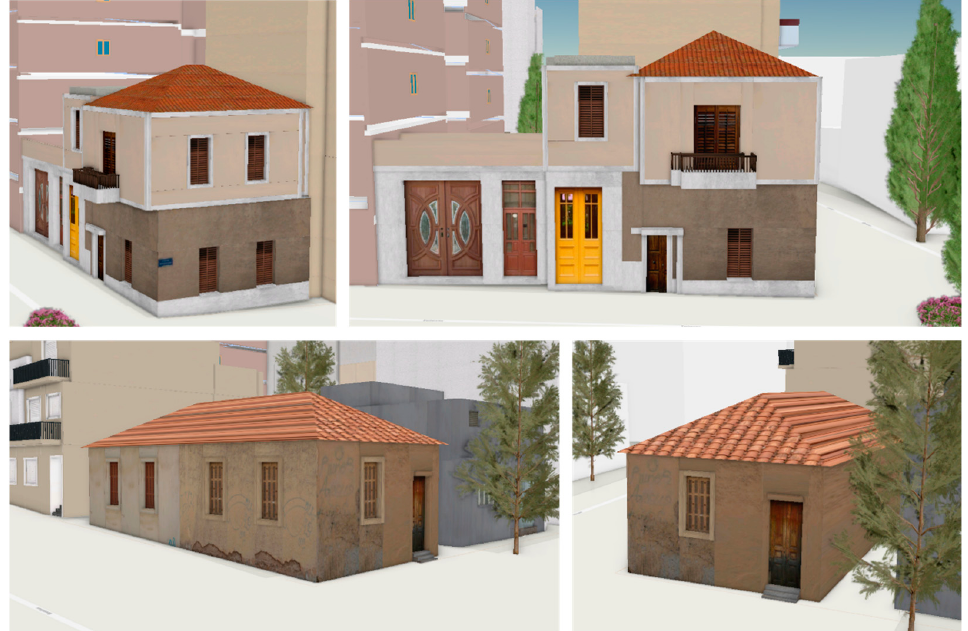
Figure 5. 3D views of the buildings at LoD3 selected for the implementation of the CH preservation scenario; the building shown at the top will function as a library; the building at the bottom will function as a cultural center.